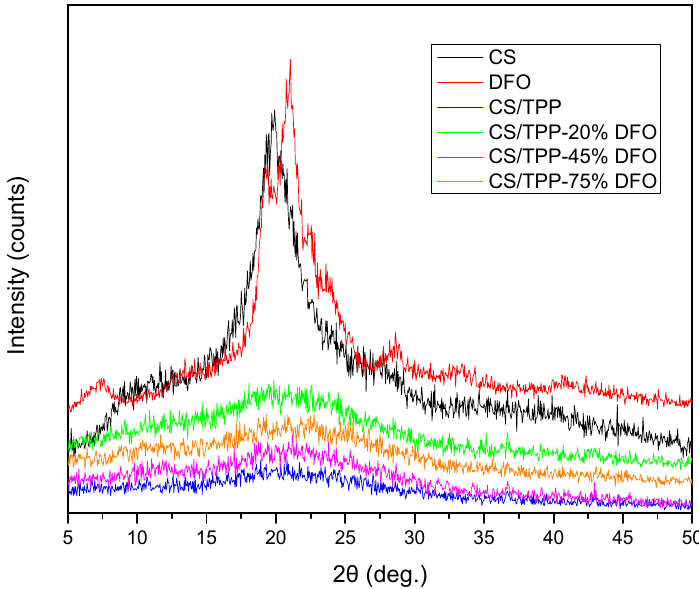
Figure 6. XRD patterns of CS, DFO, CS / TPP and their nanoparticles containing di ff erent amounts of DFO.